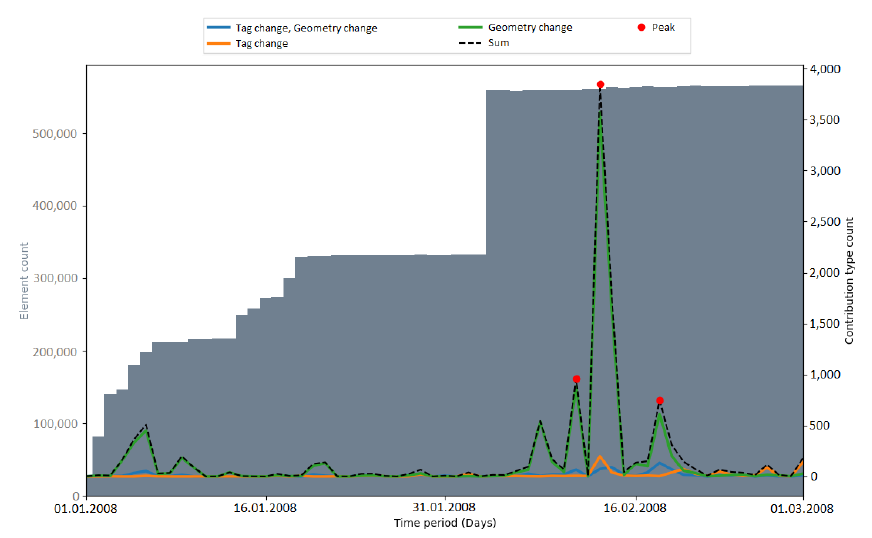
Figure A12. Contribution types during the PGS import.